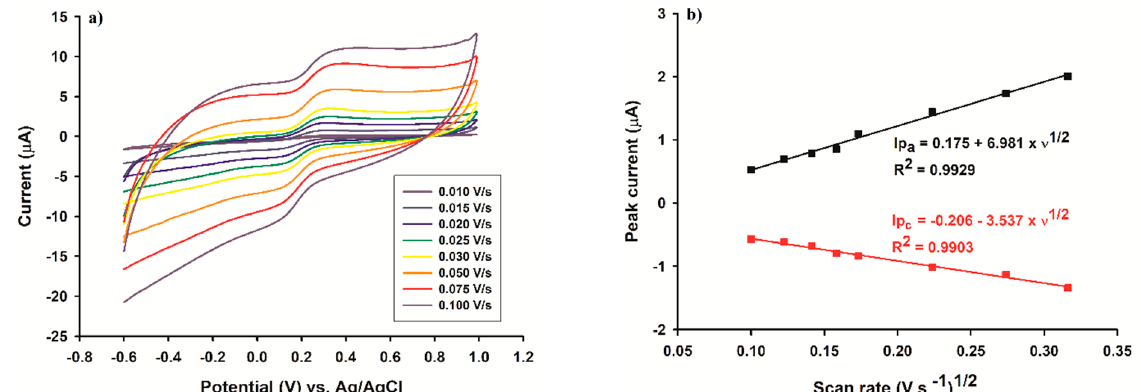
Figure 2. ( a ) Cyclic voltammograms in a solution of 5.0 × 10 − 3 mol L − 1 K 3 [Fe(CN) 6 ] (0.1 mol L − 1 KCl) at different scan rates from 0.010 to 0.100 V s − 1 using the Fe(TPFPP)Cl/rGO@Pd0 sensor (working conditions: potential range from − 0.6 to 1.0 V and step potential 0.025 V). ( b ) Dependence of the peak current on the square root of the scan rate using the Fe(TPFPP)Cl/rGO@Pd0 sensor .